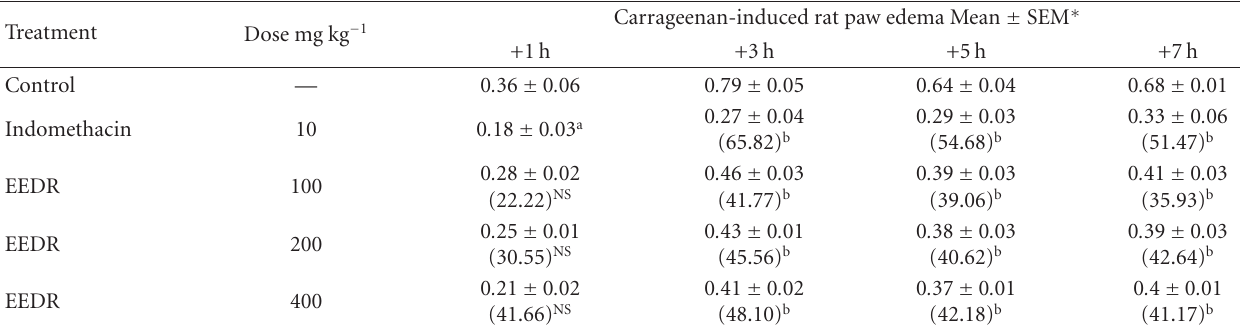
Table 1: E ff ect of ethanol extract of Delonix regia (100, 200, and 400 mg/kg) on paw volume in carrageenan-induced paw edema rats. Treatment